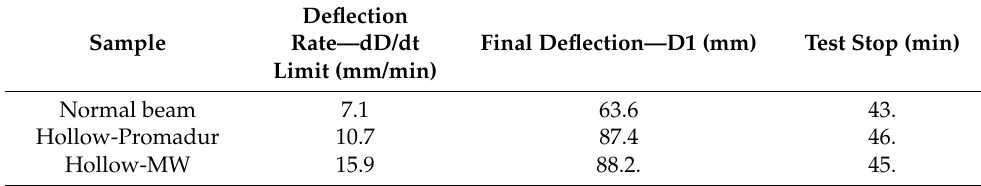
Table 8. Deflection and deflection rate.